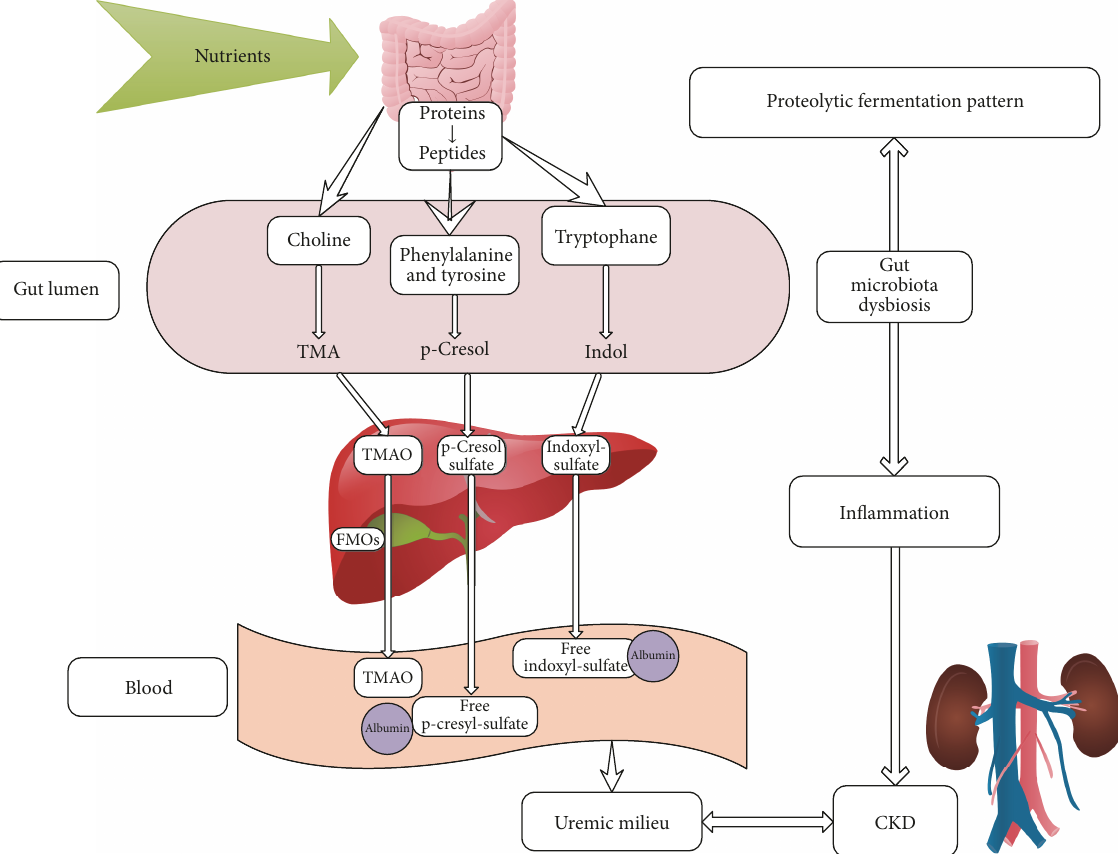
Figure 1: The pathway followed by the uremic metabolites (TMAO, p-cresyl sulfate, and indoxyl sulfate) in the setting of the uremic milieu, characteristic to CKD. The dysbiosis of gut microbiota contributes to the establishment of a proteolytic fermentation pattern, by enhancing the bacteria types that produce uremic